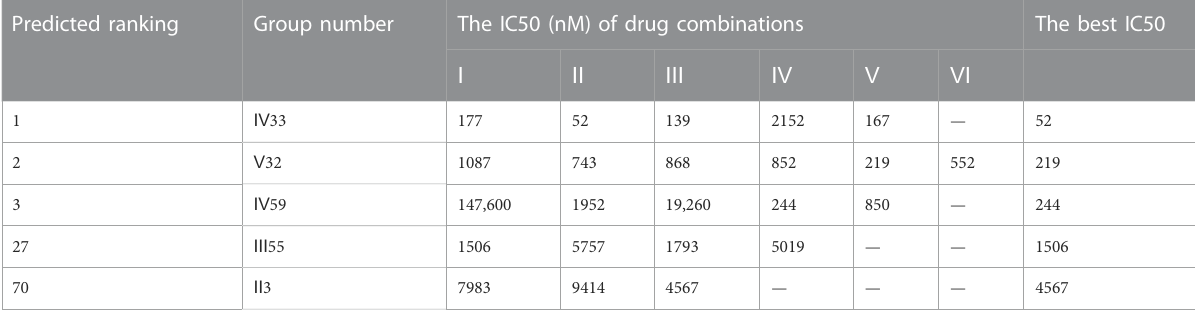
TABLE 8 The anti-cancer effects of drug combinations on MDA-MB-231 cells. Predicted ranking